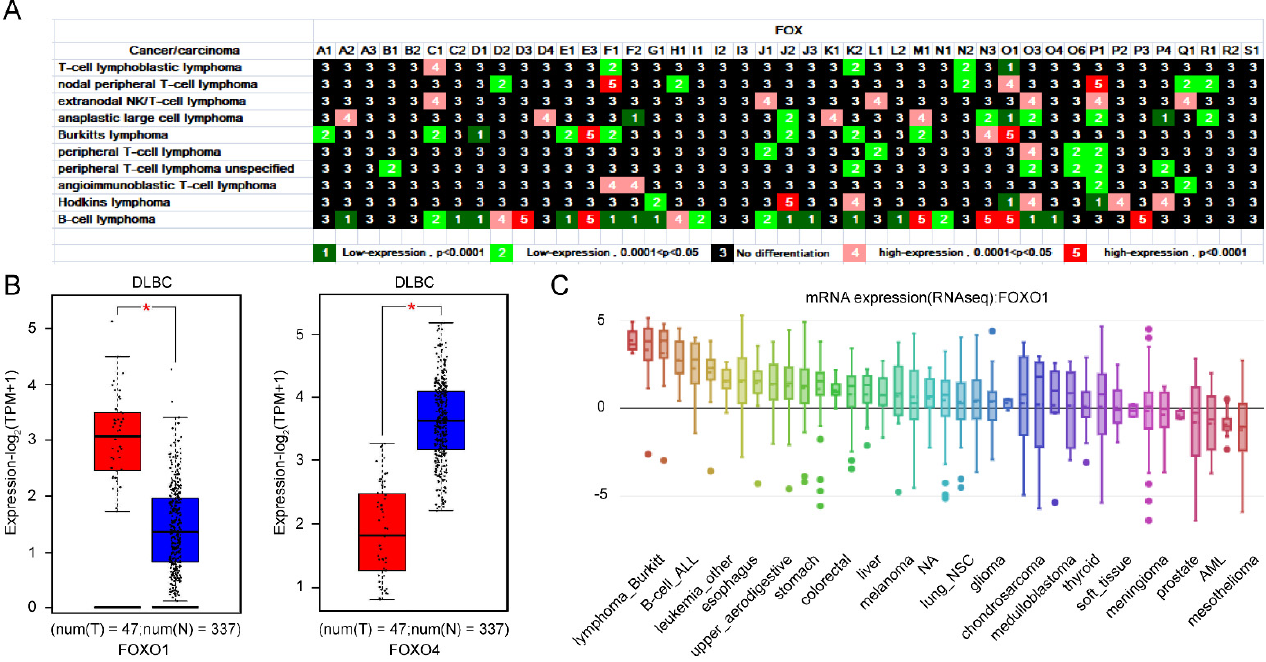
Figure 2. Differential expression of FOX genes in lymphoma ( A ). ( B ) The expression level of FOXO1 and FOXO4 between DLBC and normal tissues. ( C ) Characterization of FOXO1 in cancer cell lines. p values less than 0.05 were considered to be statistically significant, * p < 0.05.